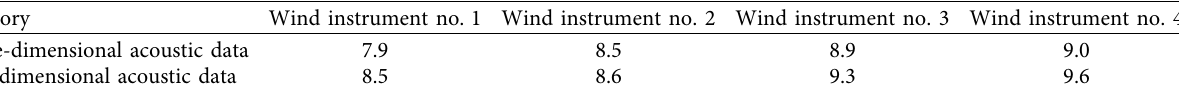
Table 3: Evaluation and recognition of experimental targets by professional music teachers.